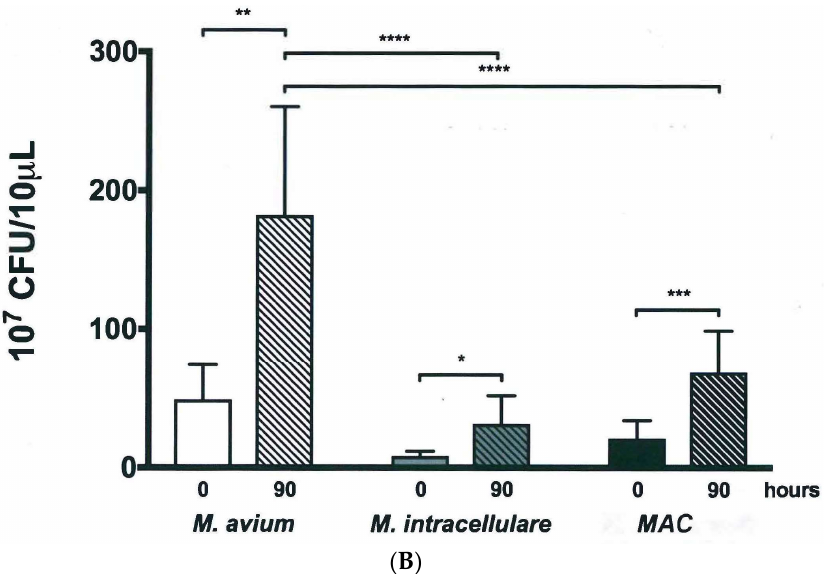
Figure 4. Bacterial growth of M. avium , M. intracellulare , and MAC ( M. avium combined with M. intracellulare ) at time zero and 90 h at ( A ) 10 −6 dilutions. Increased colony forming units (CFUs) after 90 h were significant for M. intracellulare at ** p < 0.01 according to two-tailed, paired T -test analysis. Growth of M. avium and MAC ( M. avium with M. intracellulare ) after 90 h was not significant at this dilution. The CFU differences between M. avium and M. intracellulare were significant at time zero with *** p < 0.001 and at 90 h with ** p < 0.01. ( B ) 10 −7 dilutions. Increased CFUs after 90 h were significant for M. avium at ** p < 0.01, M. intracellulare at * p < 0.05, and MAC ( M. avium with M. intracellulare ) at *** p < 0.001 according to two-tailed, paired T -test analysis. The CFU differences between M. avium and M. intracellulare , and between M. avium and MAC ( M. avium with M. intracellulare ), were significant at 90 h with **** p < 0.0001, n = 7.